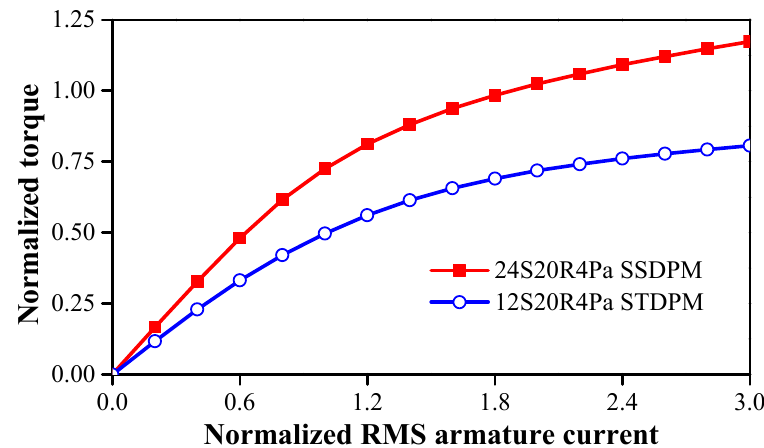
Figure 24. Torques versus current of two dual-PM machines.